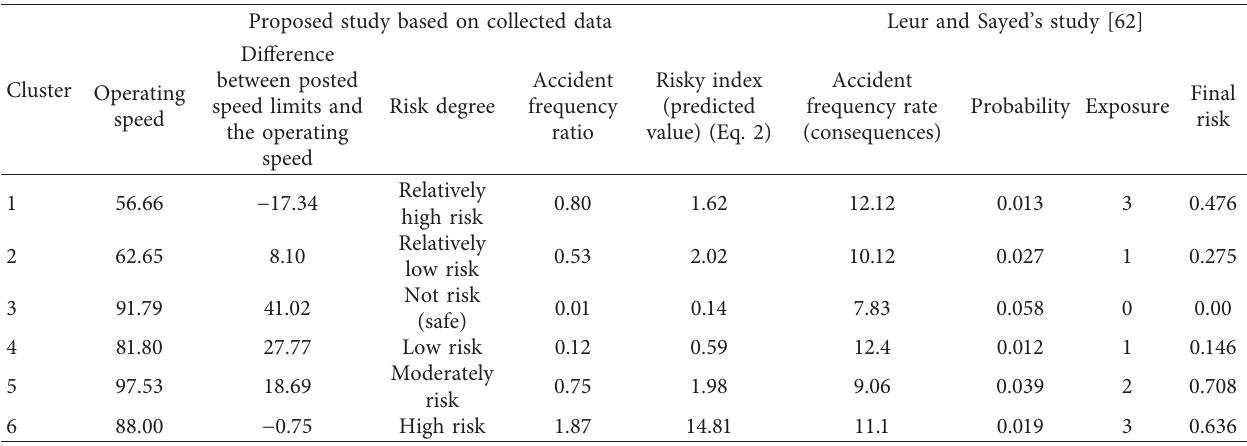
Table 7: Examination of the obtained risk value based on the proposed risk index and its comparison with that of the other studies for each cluster.